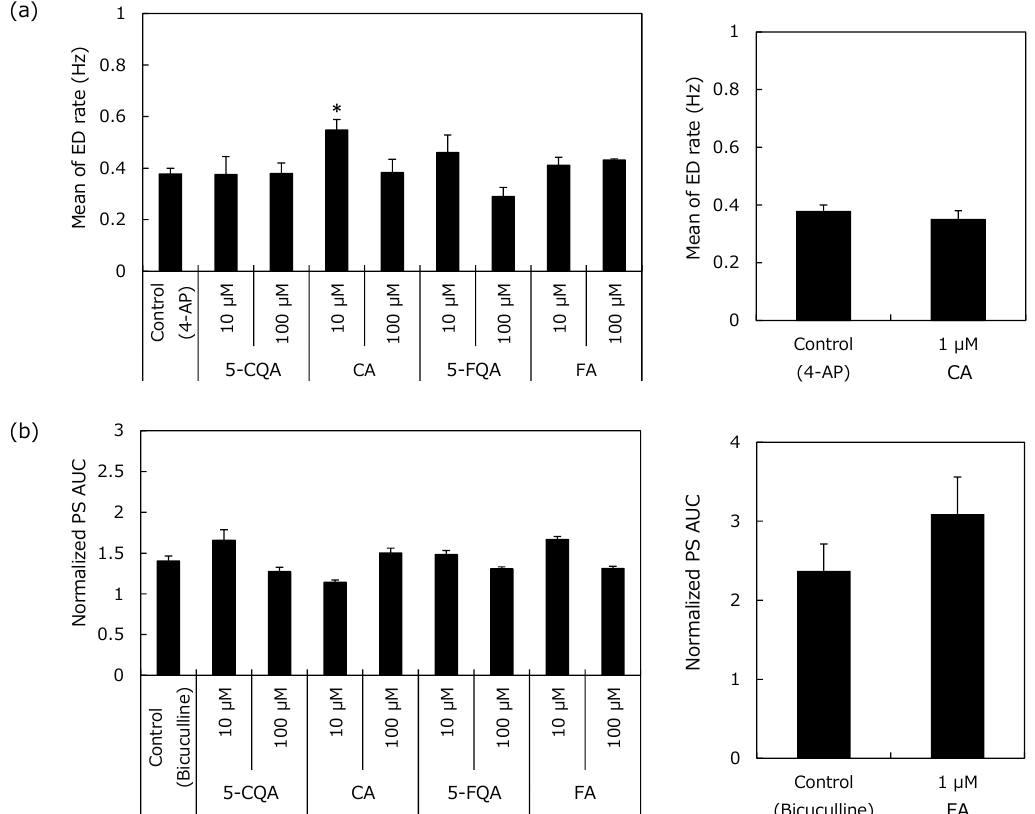
Figure 5. E ff ects of the chlorogenic acids on the electrophysiological activity of hippocampal slices with convulsive compounds. ( a ) ED rate with 10 µ M 4-aminopyridine and ( b ) Population spikes (PS) area under the curve (AUC) with 1 µ M bicuculline. ( a ) Amplitudes higher than 15 µ V were counted as ED and frequency was averaged by 30-s time slots. The frequency of ED for each condition was plotted ( ± SEM). ( b ) PS AUCs (between 2 and 100 ms after stimulus) were calculated for each electrode of each slice. Normalized PS AUCs were averaged by slices and PS mean area ( ± SEM) was plotted. Results represent mean of the last 2 min of application. * p < 0.05 to control by Sidak’s